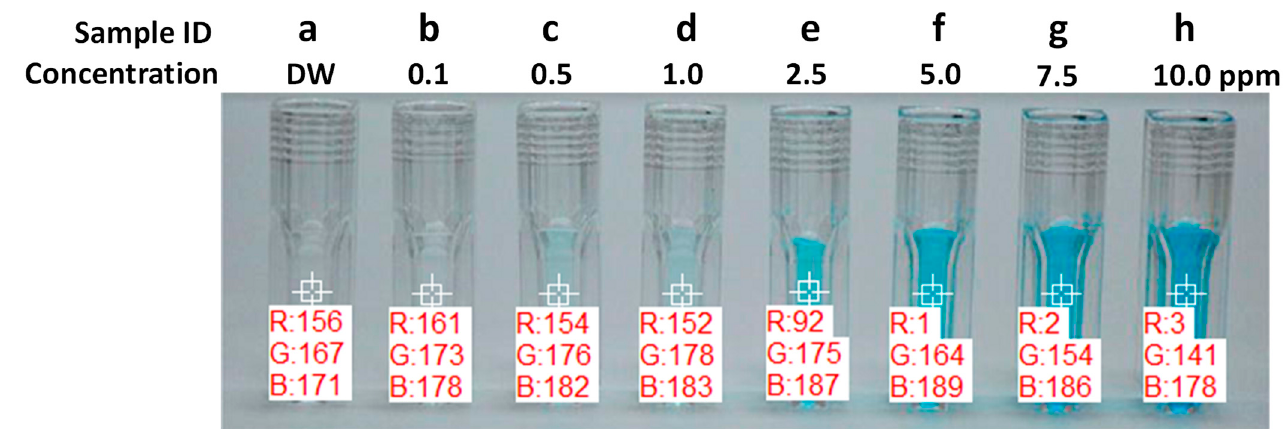
Figure 7. RGB values of MB solutions from 0.1 to 10 ppm (adapted from [23]. (15 × 15 pixel square areas were chosen for color analysis).